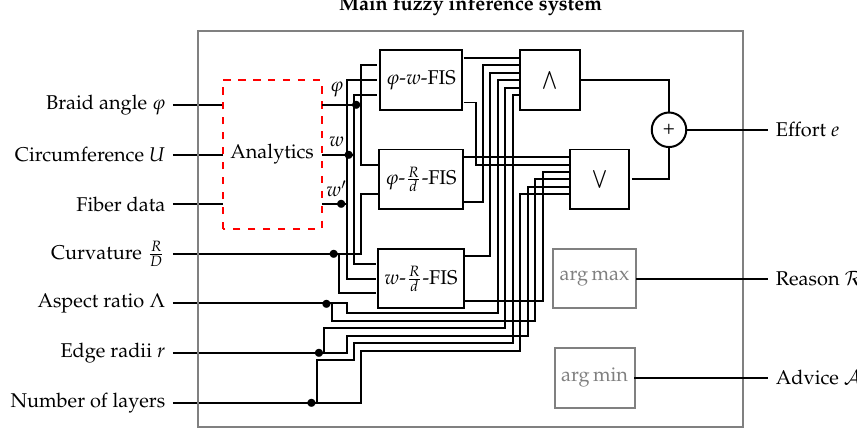
Figure A3. Illustration of the fuzzy inference system for the braiding manufacturing effort